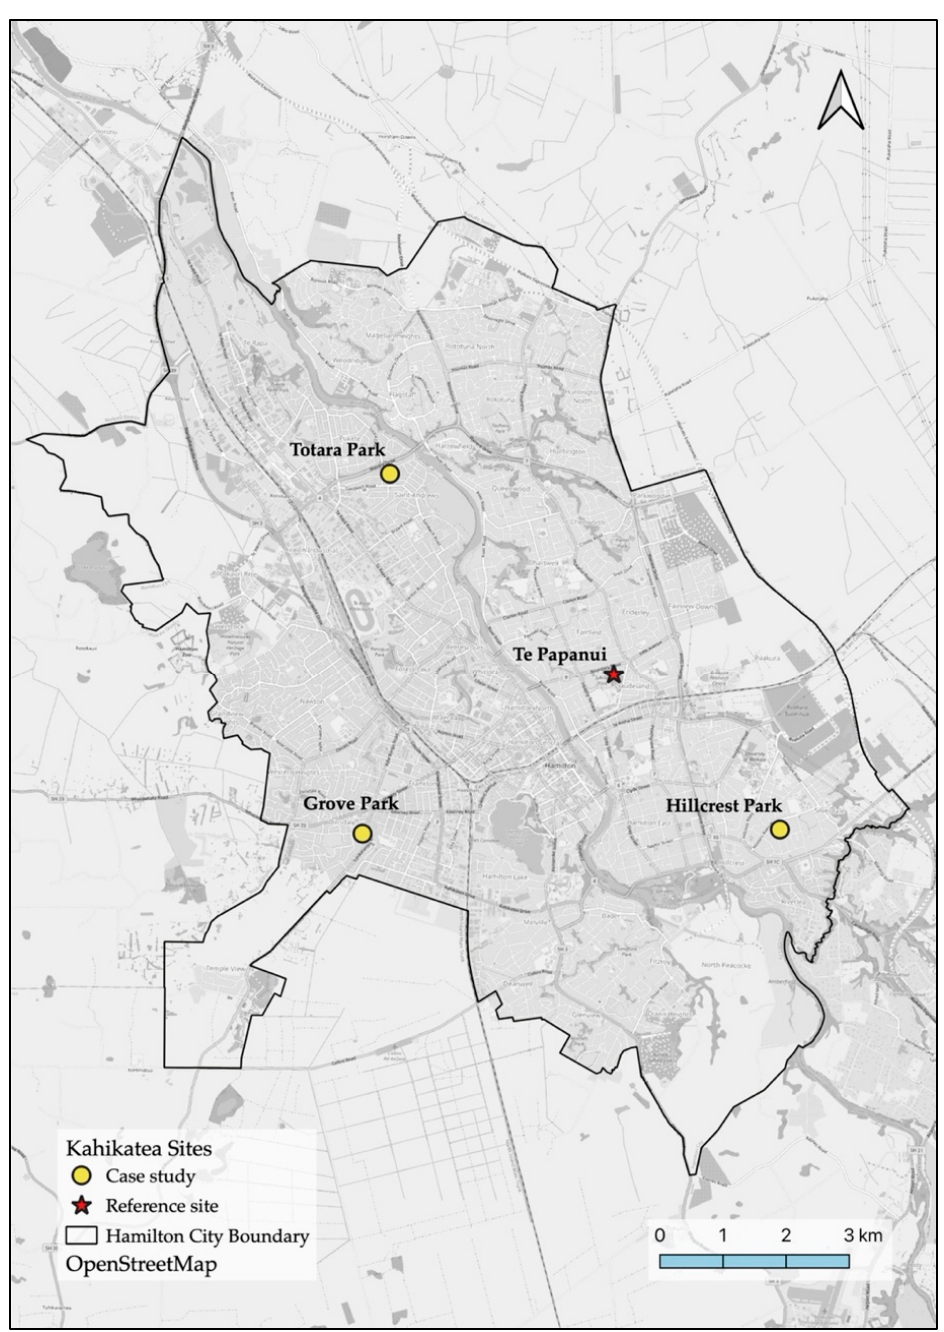
Figure 1. Location of the three kahikatea case studies and reference site. Totara Park is on the northwest, Grove Park is on the southwest, and Hillcrest Park is on the southeast of Hamilton City. Te Papanui is the reference site on the central-eastern side of the city.